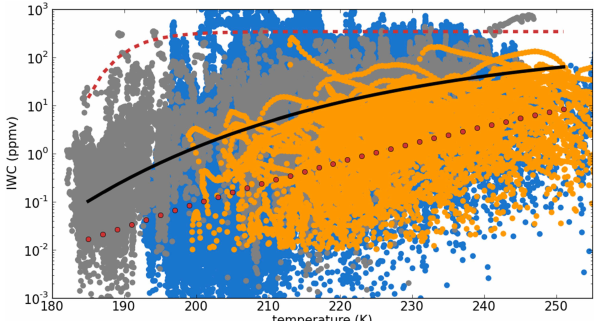
Fig. 2. IWC as a function of temperature for CLH (blue), FISH (grey) and Leo-Lidar (orange). The red dotted lines represent the IWC maximum and the minimum that can be detected with cer- tainty by CLH and FISH (Schiller et al., 2008; Kr¨amer et al., 2009), respectively. The back solid line is the median of the merged CLH and FISH dataset.